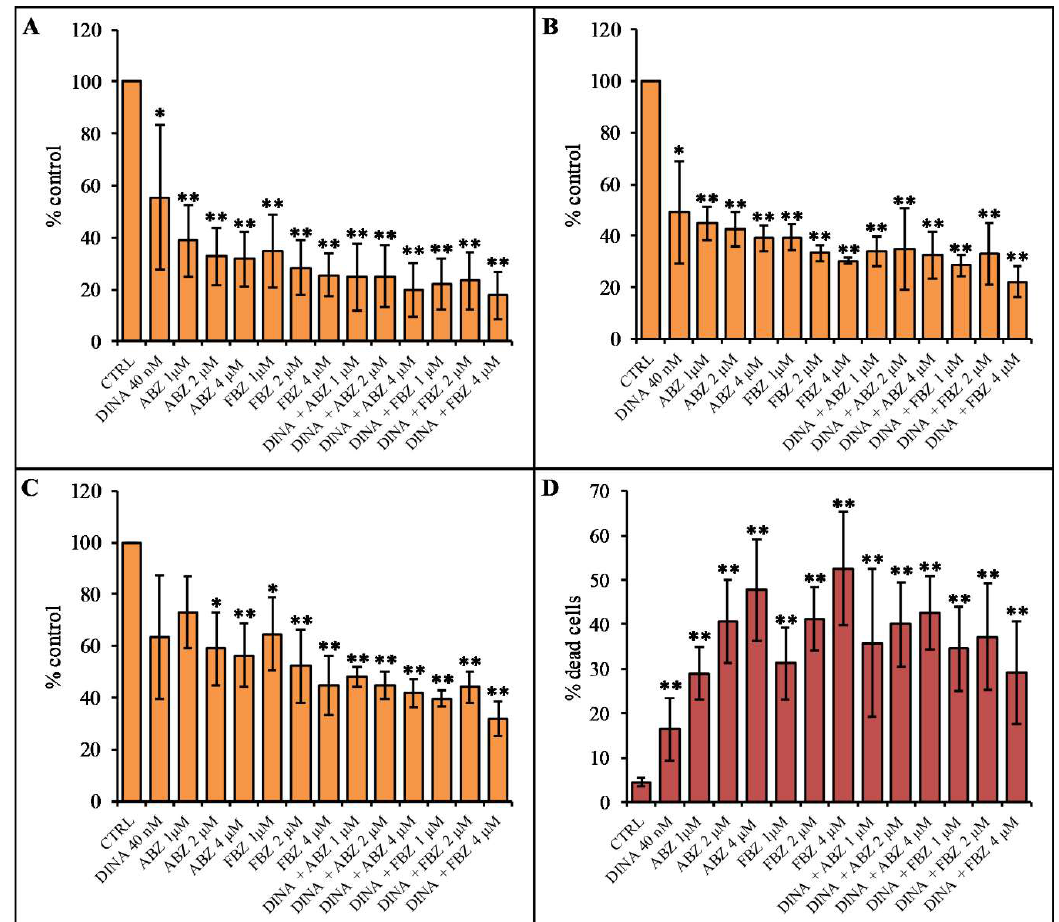
Figure 7. The effect of 48 h treatment with ABZ and FBZ on cell proliferation and viability. MTT assay of ( A ) A375 and ( B ) MCF and ( C ) HFF cells. ( D ) Flow cytometry analysis of PI-stained A375 cells. DINA (40 nM), ABZ (1, 2, and 4 μM), and FBZ (1, 2 and 4 μM) caused a significant decrease in the